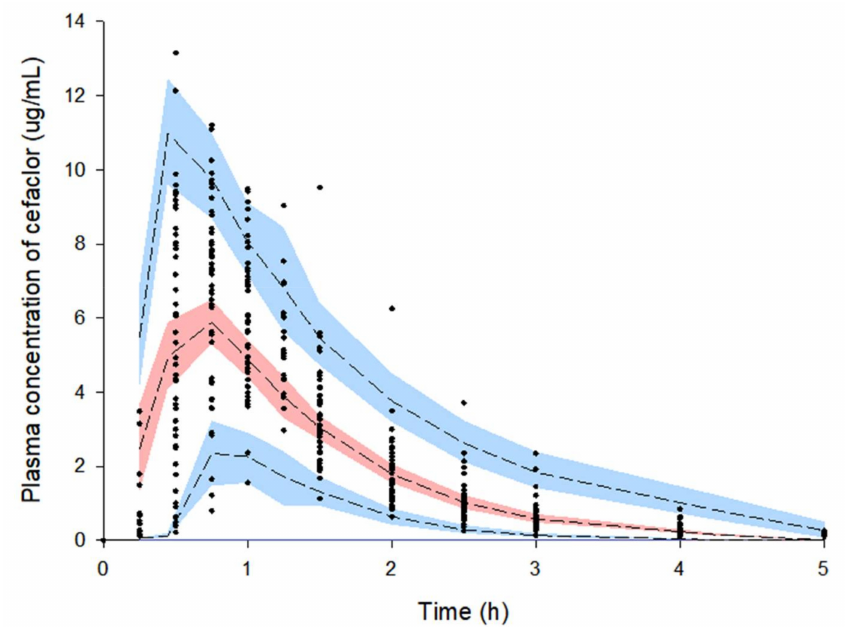
Figure 5. Visual predictive check of the final model for cefaclor. Observed concentrations were de- picted by dots. Black dashed lines indicate 95th, 50th, and 5th percentiles of predicted concentrations. Blue shaded regions indicate 95% confidence intervals for predicted 5th and 95th percentiles. Red shaded regions indicate 95% confidence intervals for the predicted 50th